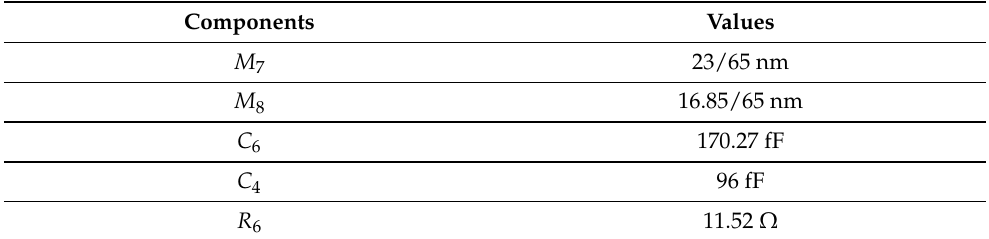
Table 2. The circuit component values of the proposed